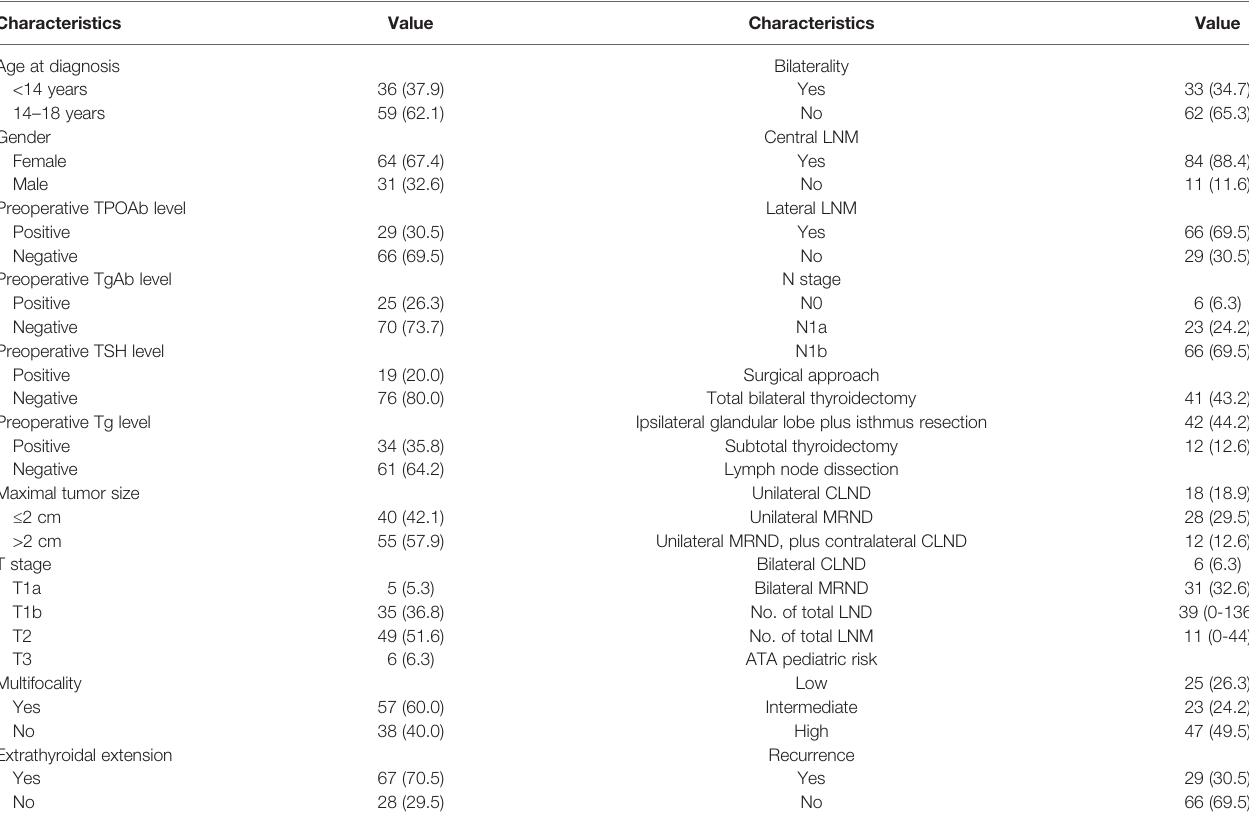
TABLE 1 | Characteristics of the study